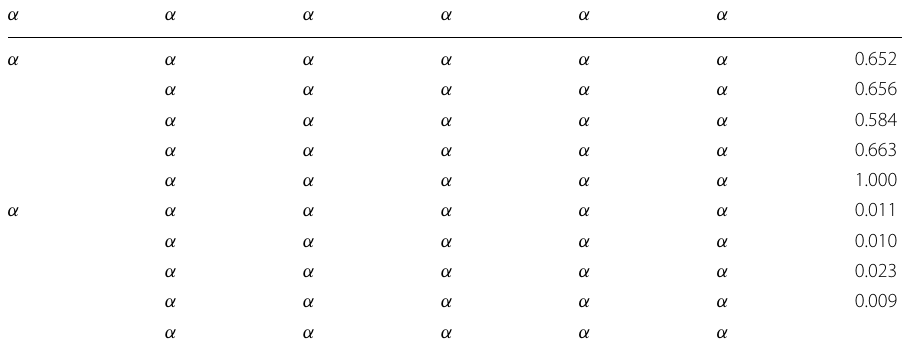
Table 2 Pearson correlation